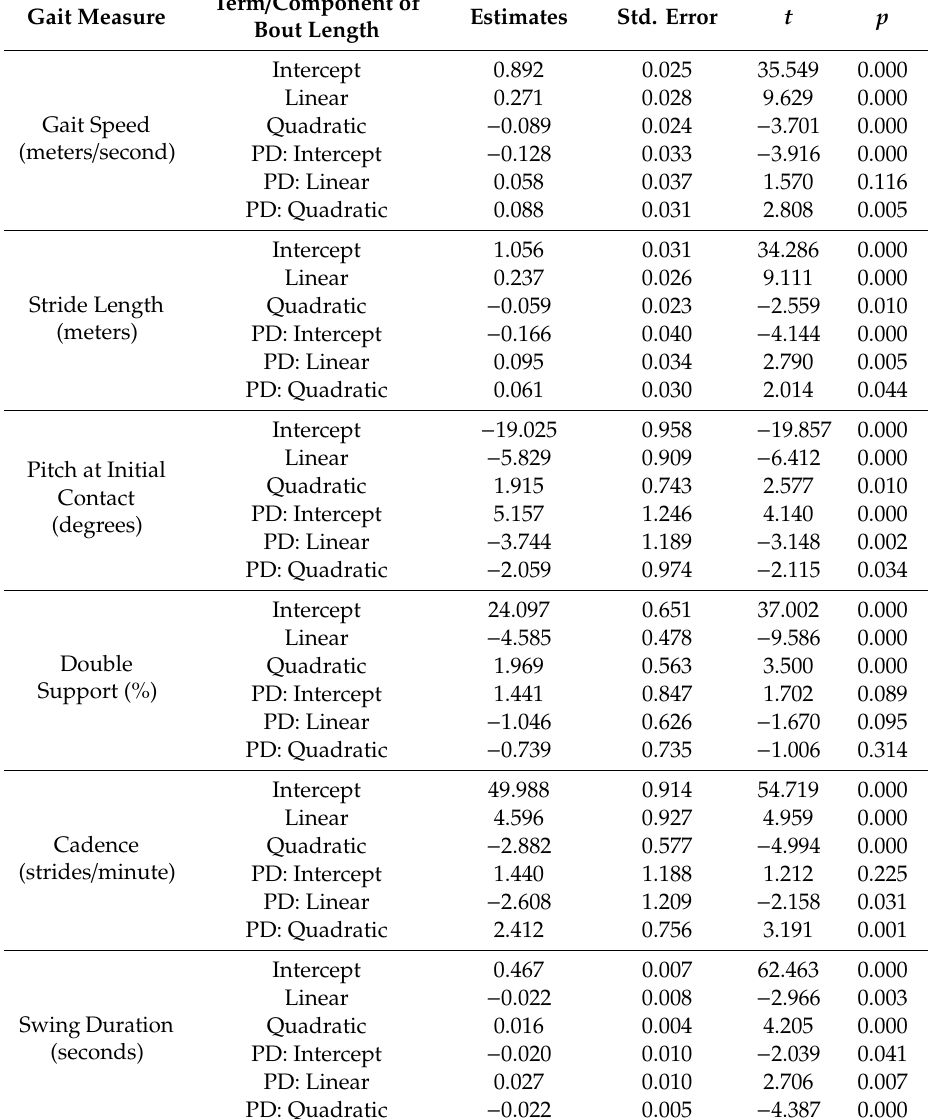
Table A1. Parameter estimates for growth curve analysis of e ff ect of group on gait measures in OA and PD